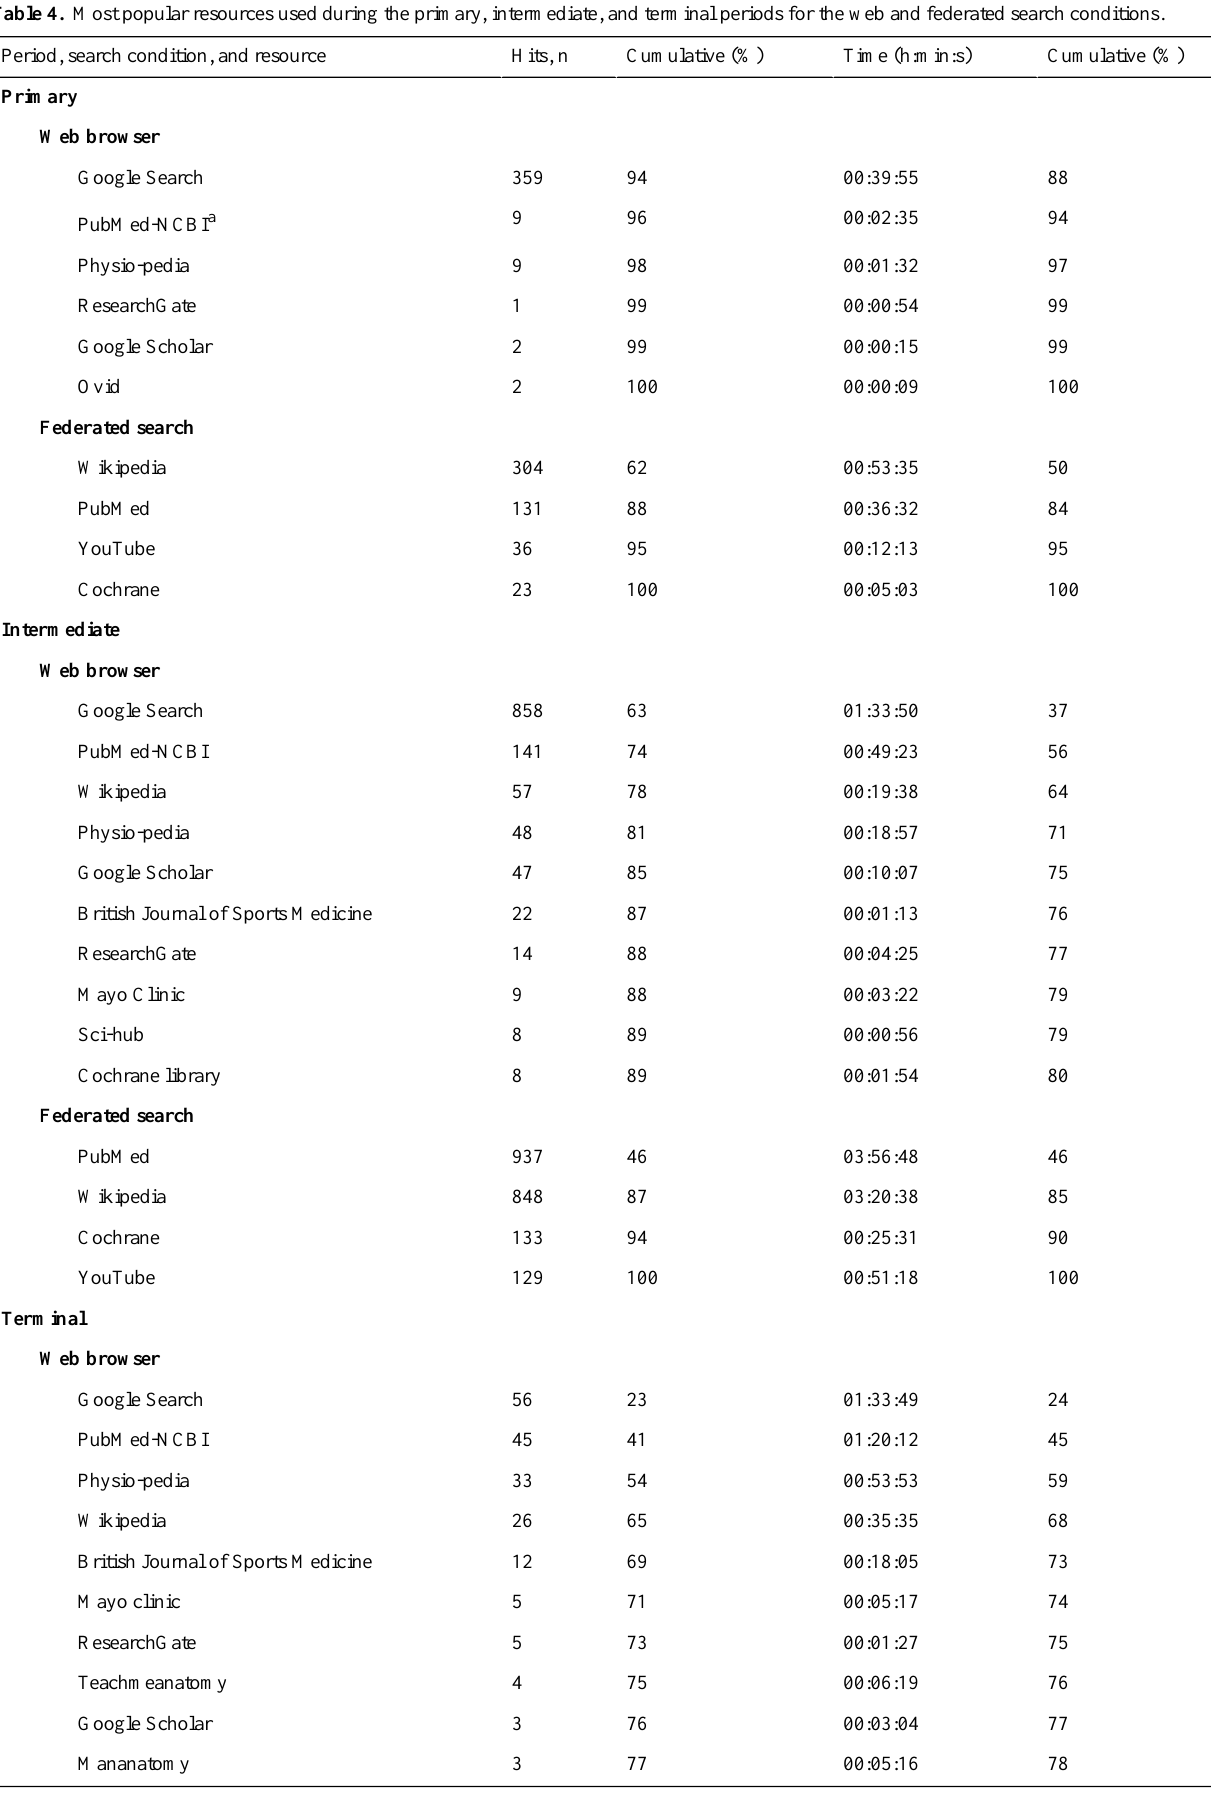
Table 4. Most popular resources used during the primary, intermediate, and terminal periods for the web and federated search